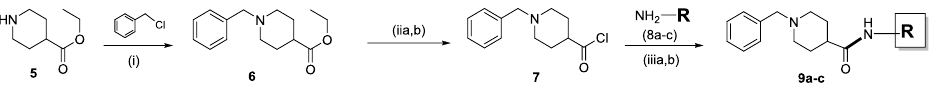
Figure 1. Structures of the synthesized hydrazones ( 4a – k ) and isonipecotates ( 9a – c ). Note that FW means Formula Weight and MP denotes Melting Point. Sci. Pharm. 2017 , 86 , 2